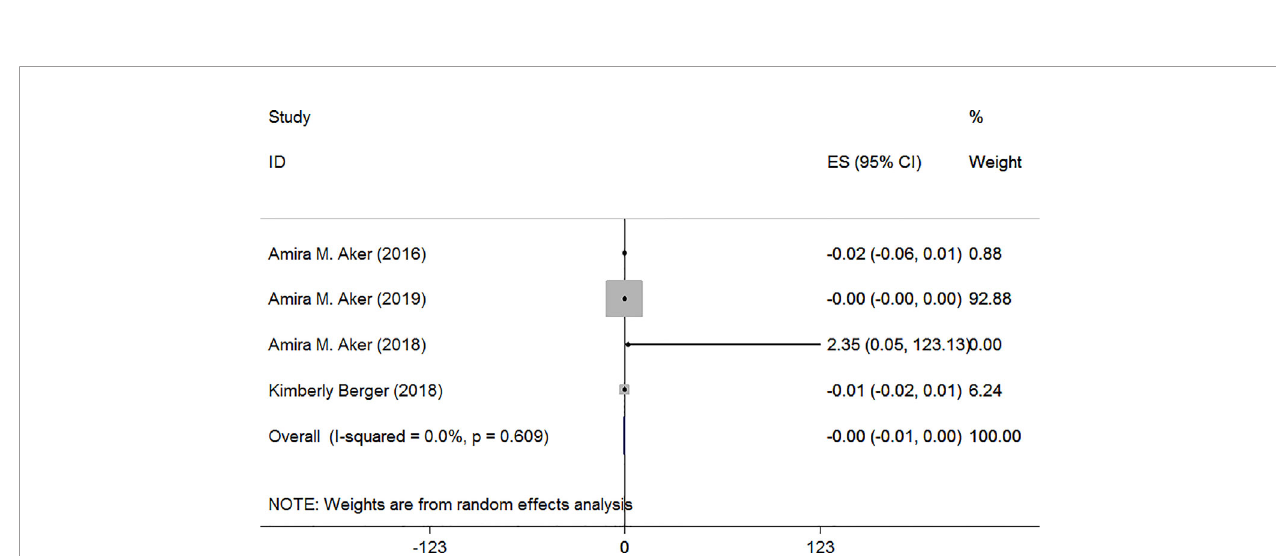
FIGURE 5 | Forest plot of prenatal exposure to TCS and maternal FT4 levels standardized using speci fi c gravity.